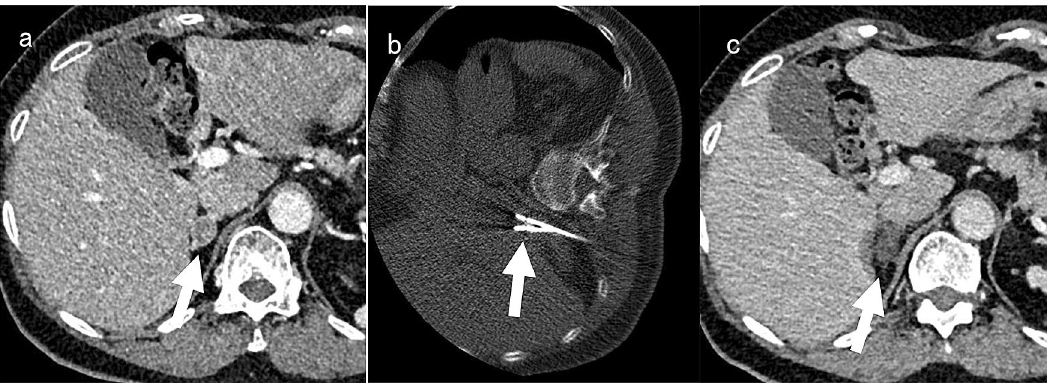
Figure 1. An example of CT-guided radiofrequency ablation for right adrenal adenoma. ( a ): Pre-procedural dynamic CT showed14 mm well-circumscribed right adrenal adenoma (arrow). ( b ): Two electrodes were inserted into the tumor by CT-guidance in the right lateral decubitus position, then radiofrequency ablation was performed (arrow). ( c ): The adrenal adenoma did not show contrast enhancement on post-procedural